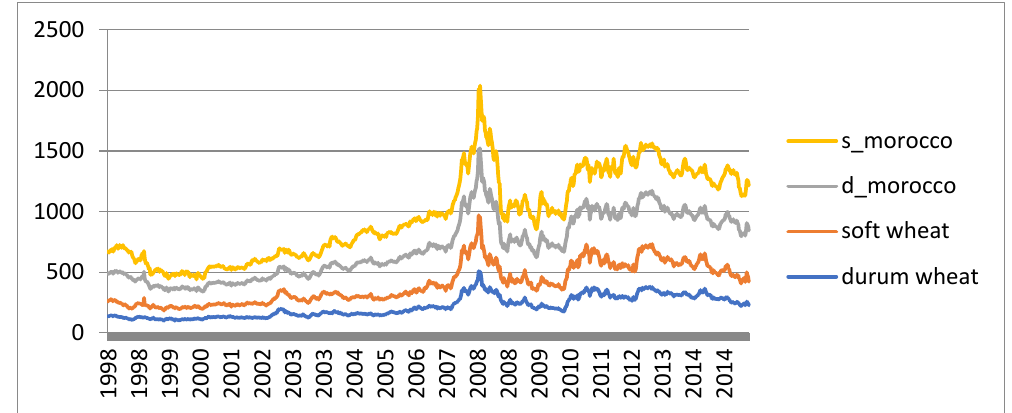
Figure 1. Morocco and world cereal prices.